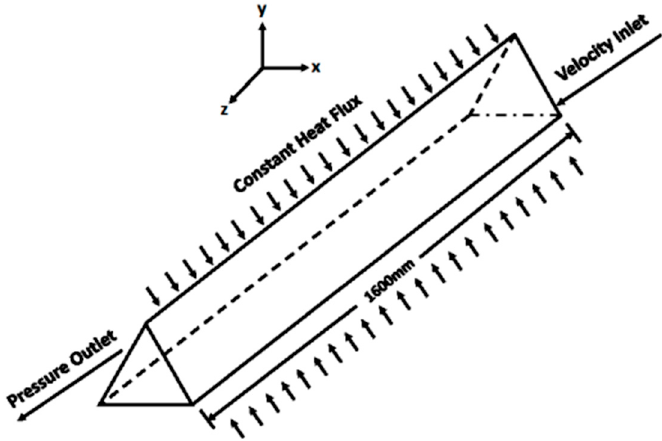
Figure 1. Geometrical configuration in the numerical simulation.